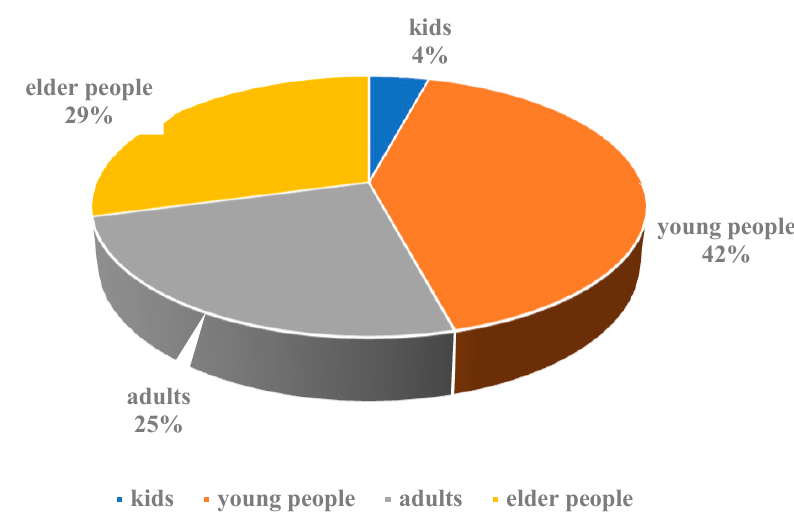
Figure 4. People who create the most dangerous situations by age group.